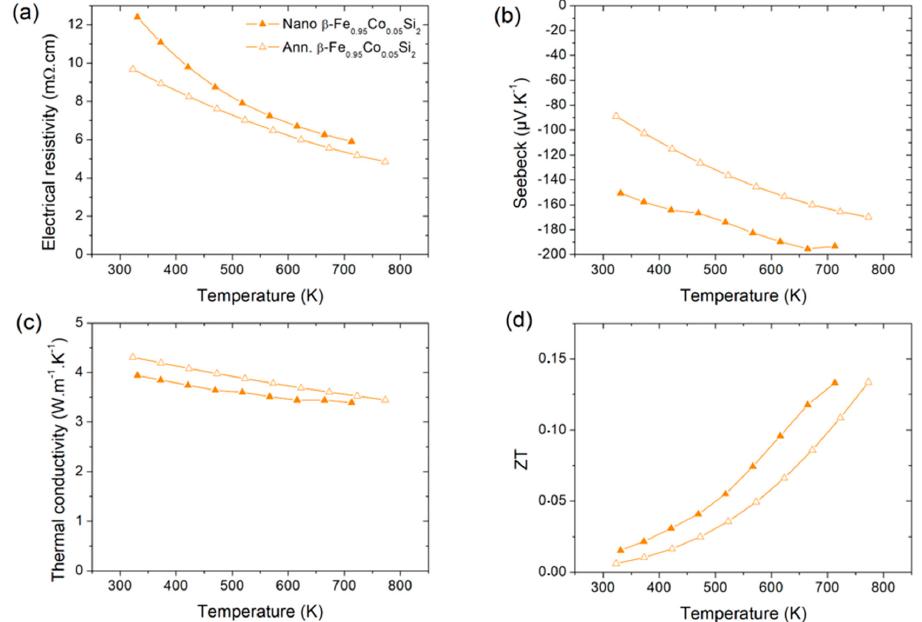
Figure 7. Thermoelectric properties of β -Fe 0.95 Co 0.05 Si 2 ( a ) electrical resistivity, ( b ) Seebeck coefficient, ( c ) Thermal conduc- tivity, ( d ) ZT.